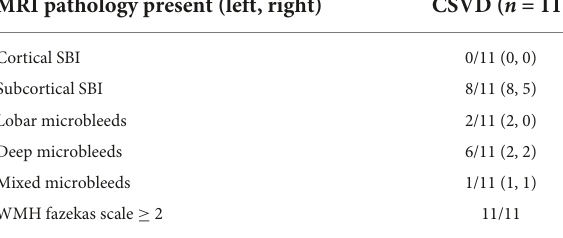
TABLE 2 Summary of magnetic resonance imaging (MRI) findings. MRI pathology present (left, right)